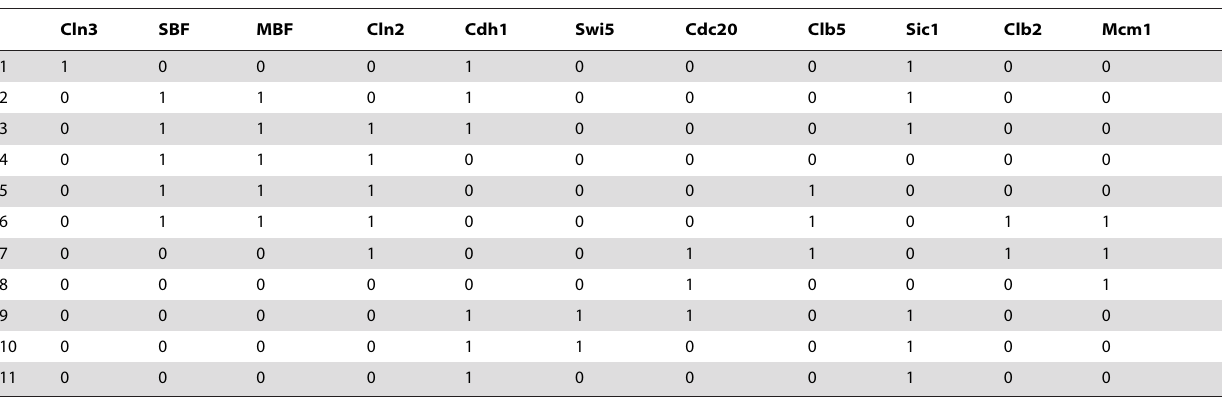
Table 1. The biological pathway of budding yeast cell cycle.